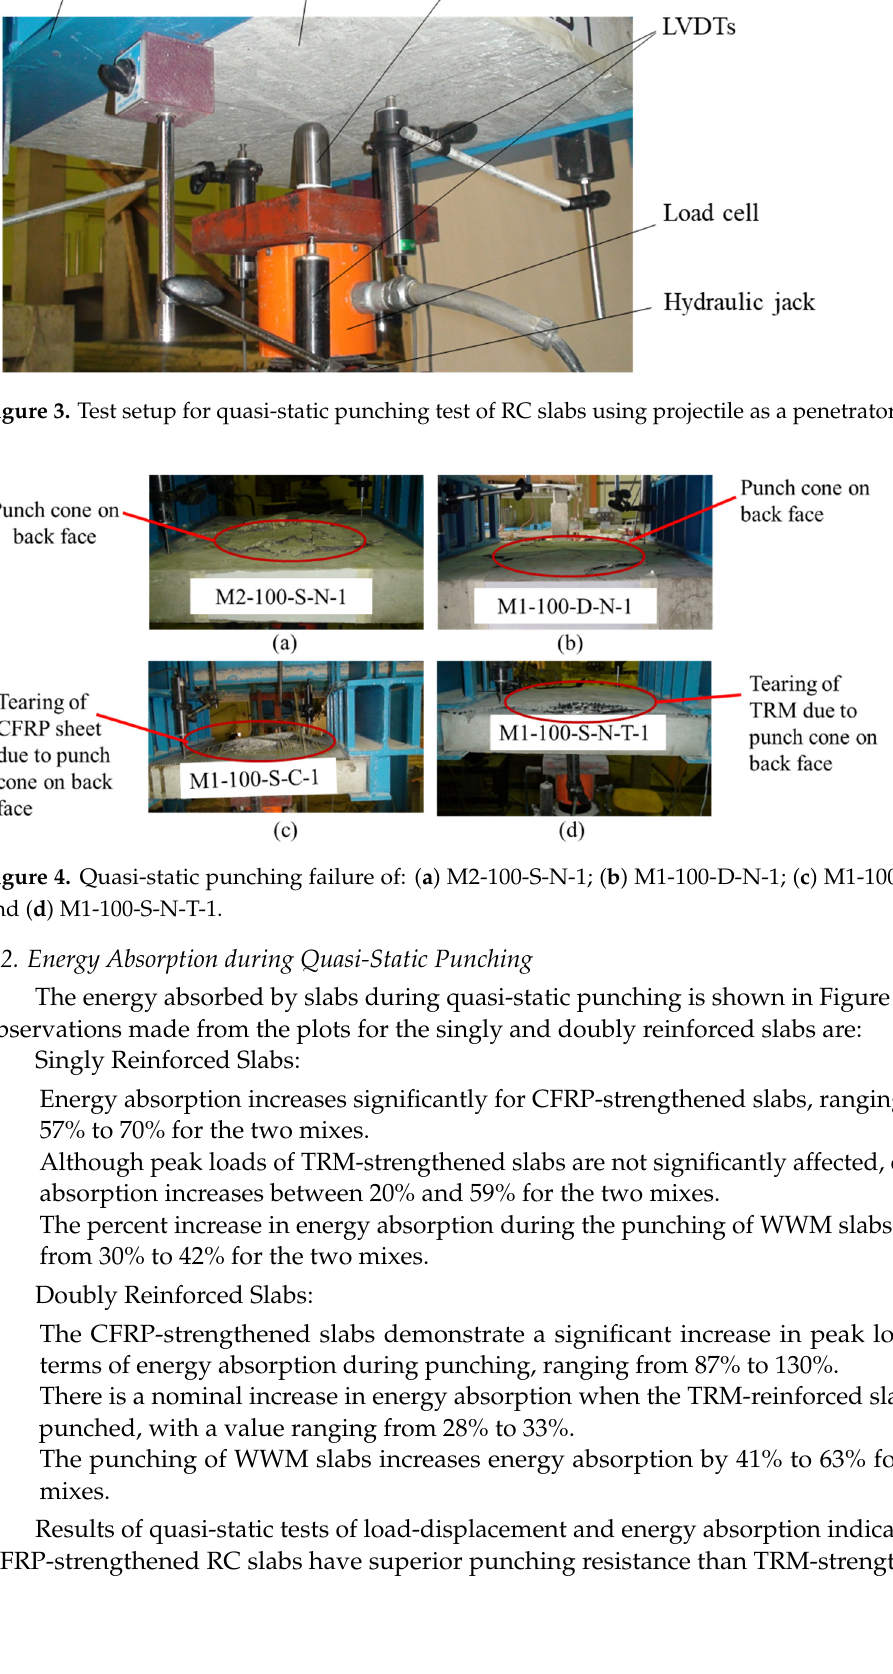
Figure 3. Test setup for quasi-static punching test of RC slabs using projectile as a penetrator.